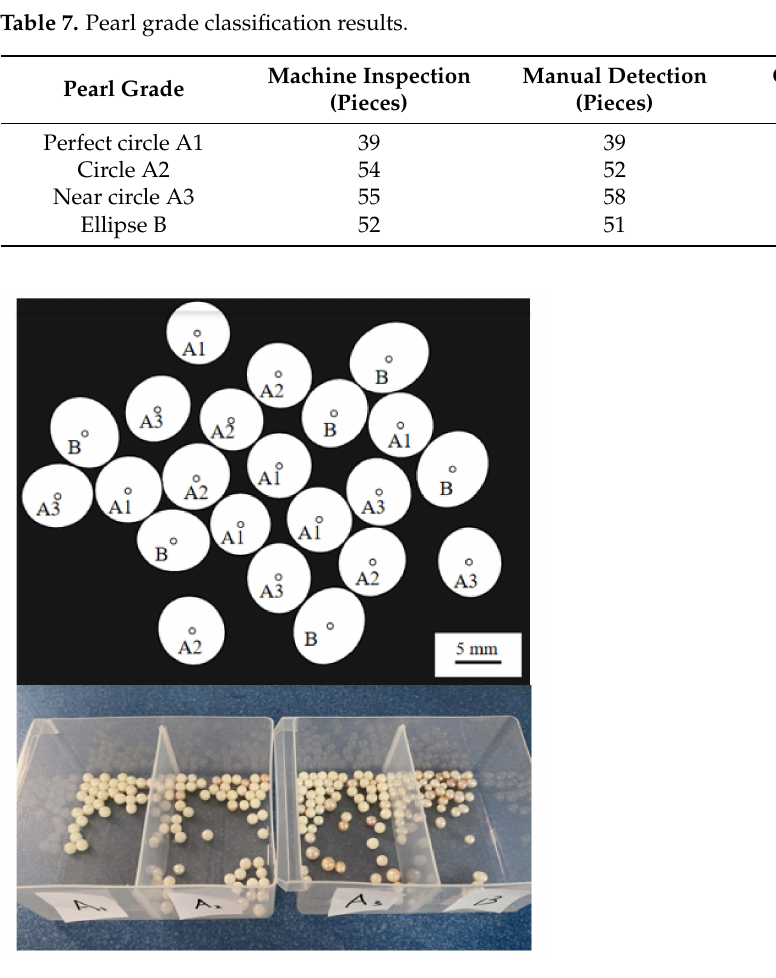
Figure 12. Robot sorting